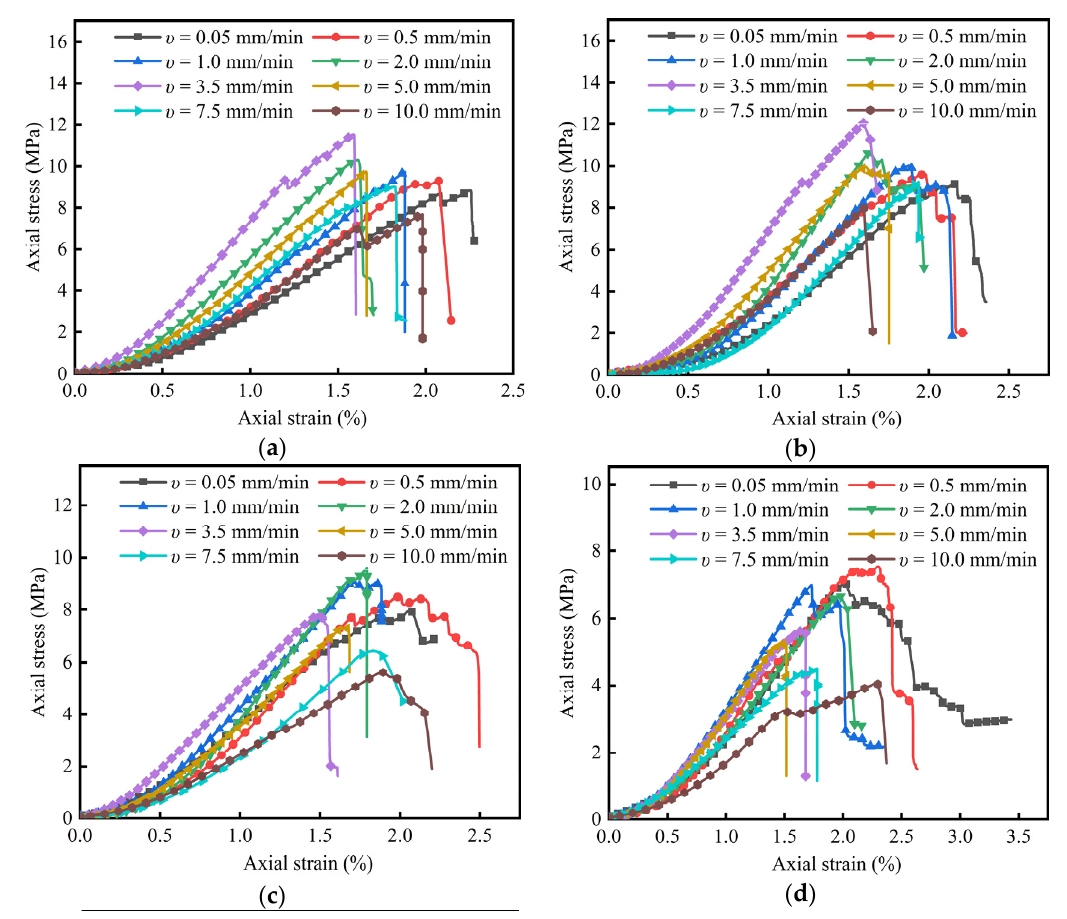
Typical stress-strain